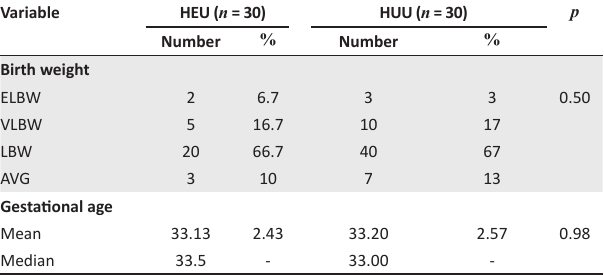
TABLE 1: Demographic information for human immunodeficiency virus - exposed uninfected and human immunodeficiency virus-unexposed uninfected groups.